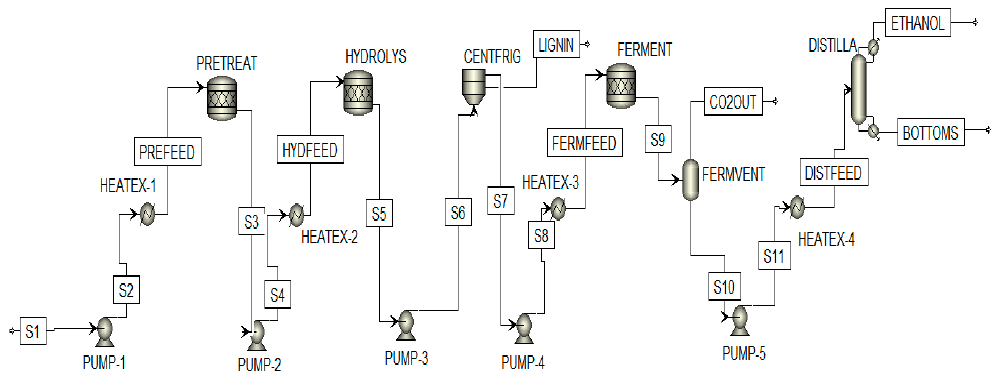
Figure 4. Aspen Plus simulation for fermentation.